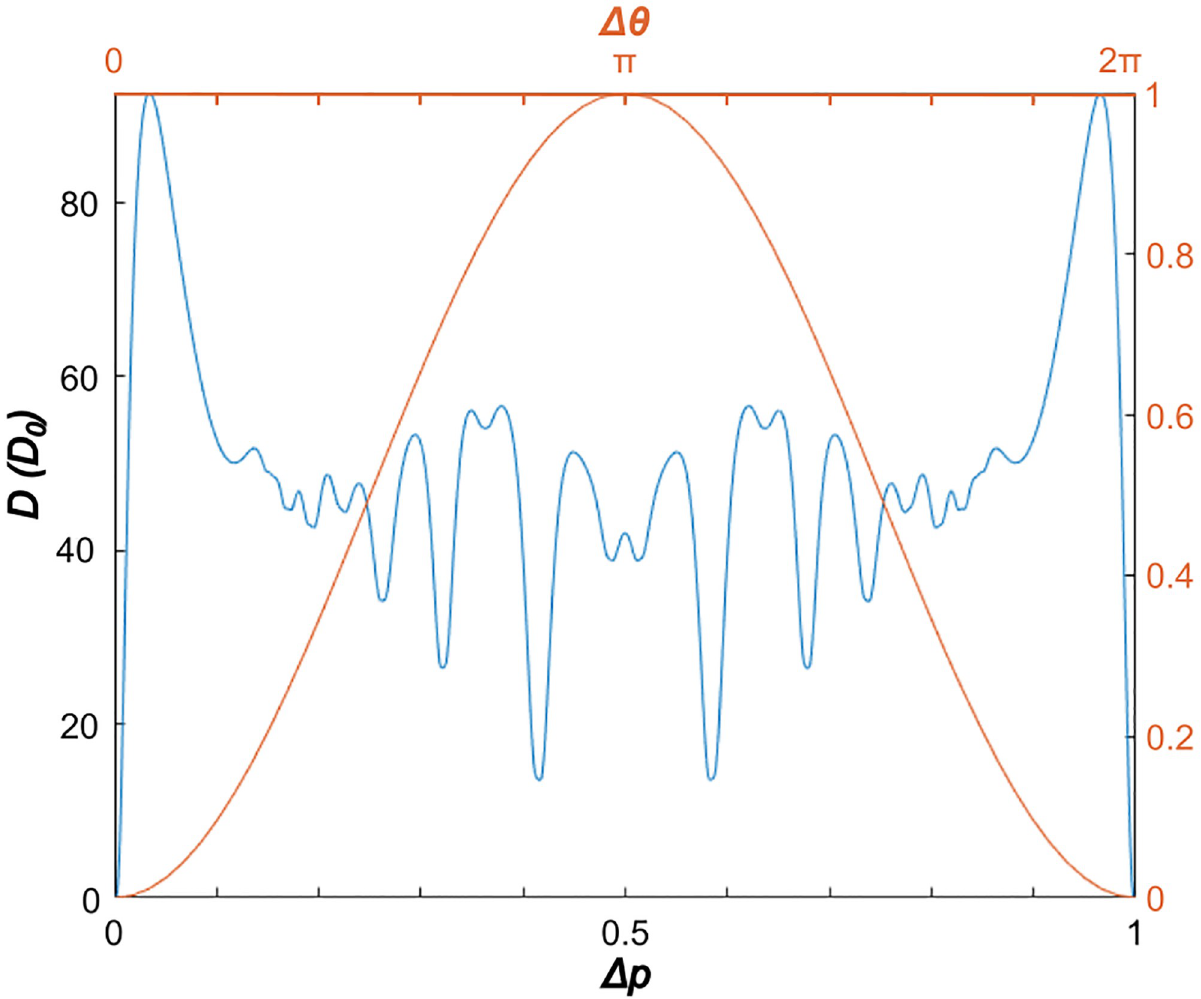
Fig 1. XY interactions. Dissonance function D (blue) as a function of logarithmic pitch difference Δ p over one octave, used here as the interaction between neighboring tones. For comparison, a more typical interaction energy / (1 − cos( Δ θ )) is shown in red.